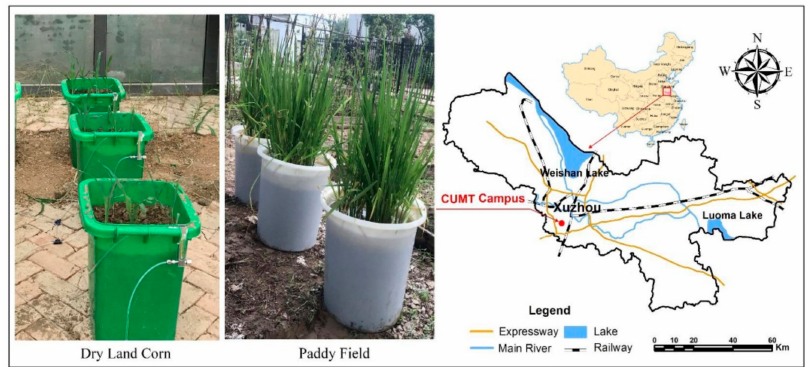
Figure 1. Location and photos of the experimental